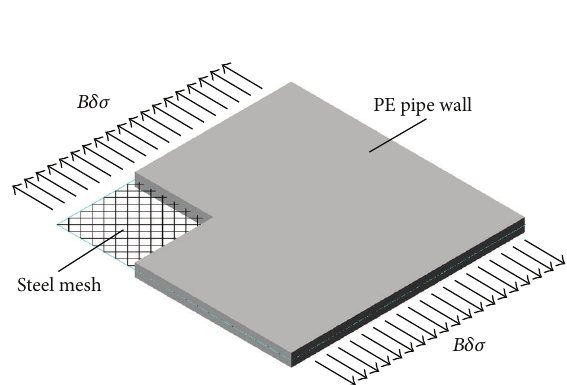
Figure 4: Force analysis of the unfolded pipe